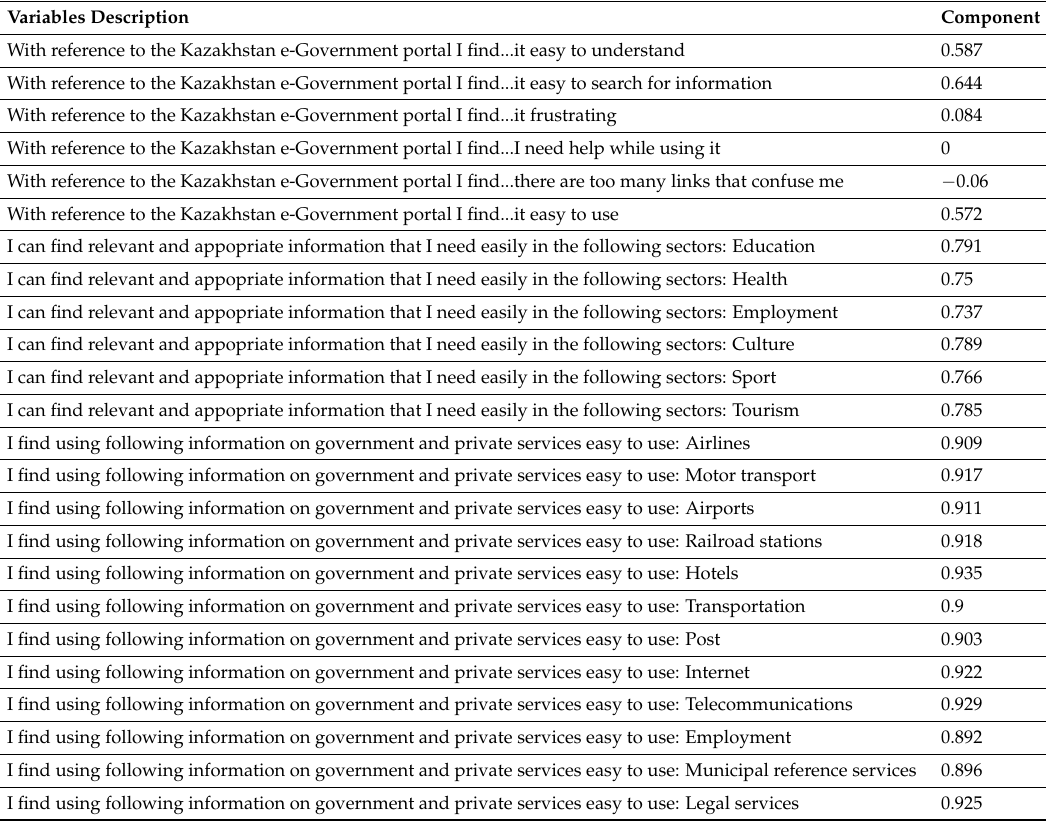
Table A6. Component matrix of PEOU constructs.